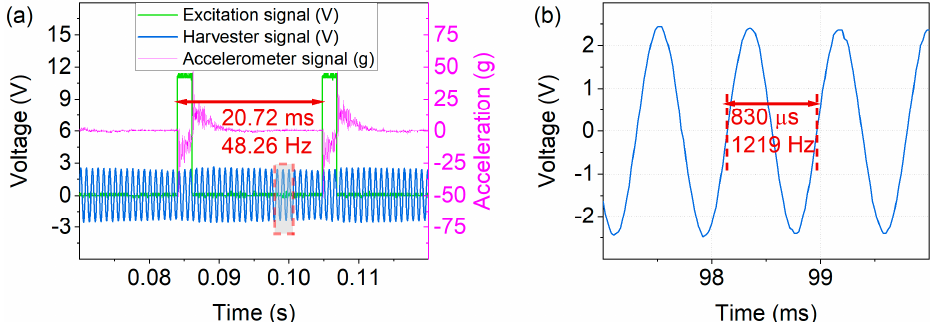
Figure 7. Mechanical excitation of unmagnetized devices. ( a ) A driving signal (f exc = 48.26 Hz, 10% duty) results in acceleration peaks of 51 g. ( b ) In between the excitation pulses the harvester oscillates at it eigenfrequency f res = 1219 Hz, delivering an output voltage of V PP ≈ 5 V.